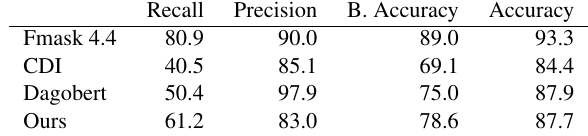
Table 2. Recall, Precision, Balanced accuracy and Accuracy